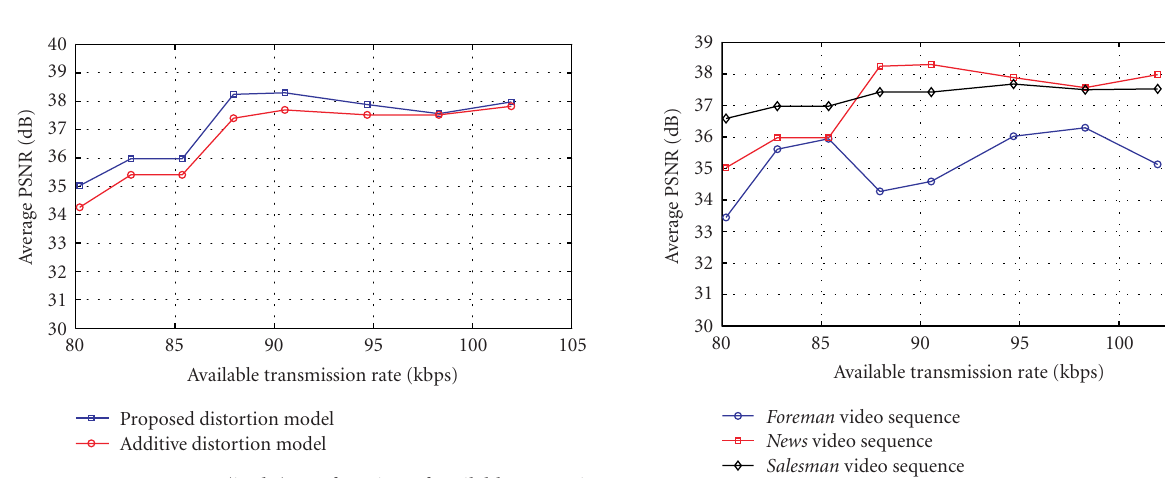
Figure 2: Average PSNR (in dB) as a function of available transmis- sion rate (in kbps) for the “even-loss distribution” algorithm. Com- parison between the proposed and the simplified “additive” distor- tion model for the video sequence News .